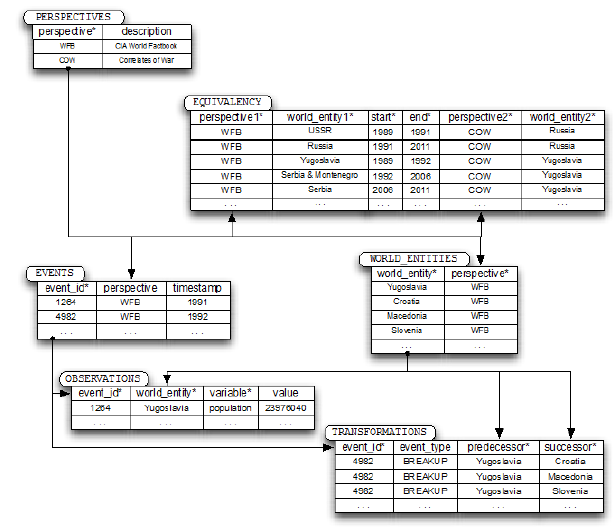
Figure 4. WSTAMP database